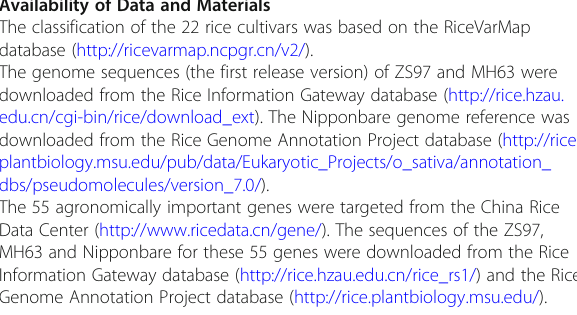
and 90bp. Figure S3 . Comparation of potential LInDel markers among three genomes. Figure S4. Dendrogram of 22 rice varieties derived by UPGMA from 312 LInDel markers. Figure S5. Detection of the hybrids Shanyou 63 from ZS97 and MH63 (MH63 as female parent). Figure S6. The genetic linkage map of 20 LInDel markers on chromosome 1. Four breeding markers were labeled on the corresponding position. Additional file 2. The 20-90 bp LInDels between ZS97 and MH63. Additional file 3. The 30-55 bp LInDels between ZS97 and MH63 for markers design. Additional file 4. The 1838 unique LInDel markers designed by 30-55 bp LInDels. Additional file 5. The 30-55 bp LInDels between ZS97 and Nipponbare or between MH63 and Nipponbare. Additional file 6. The 4744 unique LInDel markers designed by the 30- 55 bp LInDels Additional file 7. The 346 LInDel markers chosen for validation.